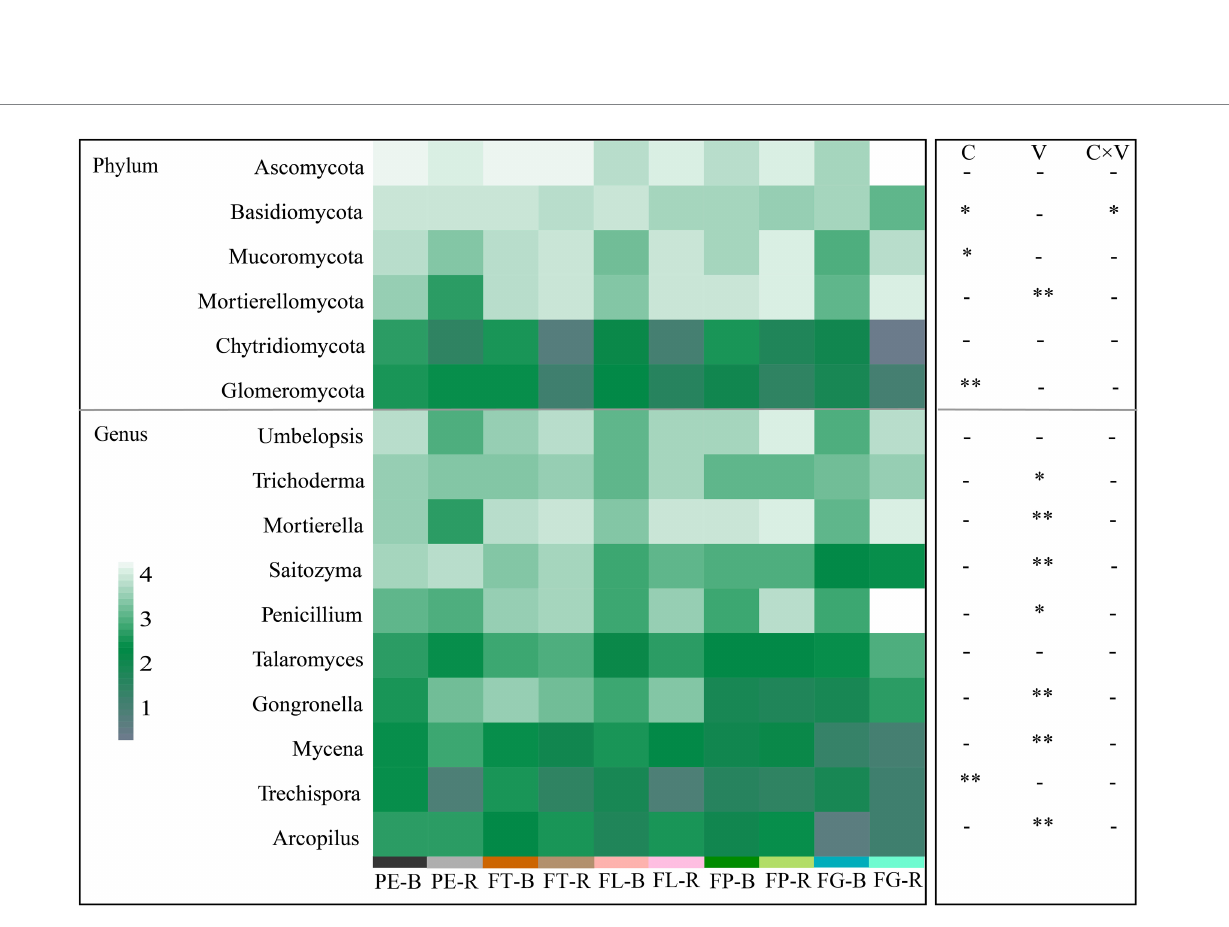
FIGURE 3 Effects of soil compartment, bamboo variety, and their interactions on the major fungal phyla (top 6) and genera (top 10). C, soil compartment; V, bamboo variety. “*” p < 0.05, “**” p < 0.01. Rhizosphere soil (R): PE-R, Phyllostachys edulis ; FT-R, P. edulis f. tao kiang ; FL-R, P. edulis f. luteosulcata; FP-R, P. edulis f. pachyloen; FG-R, P. edulis f. gracilis . Bulk soil (B): PE-B, P. edulis; FT-B, P. edulis f. tao kiang; FL-B, P. edulis f. luteosulcata; FP-B, P. edulis f. pachyloen ; FG- B, P. edulis f. gracilis